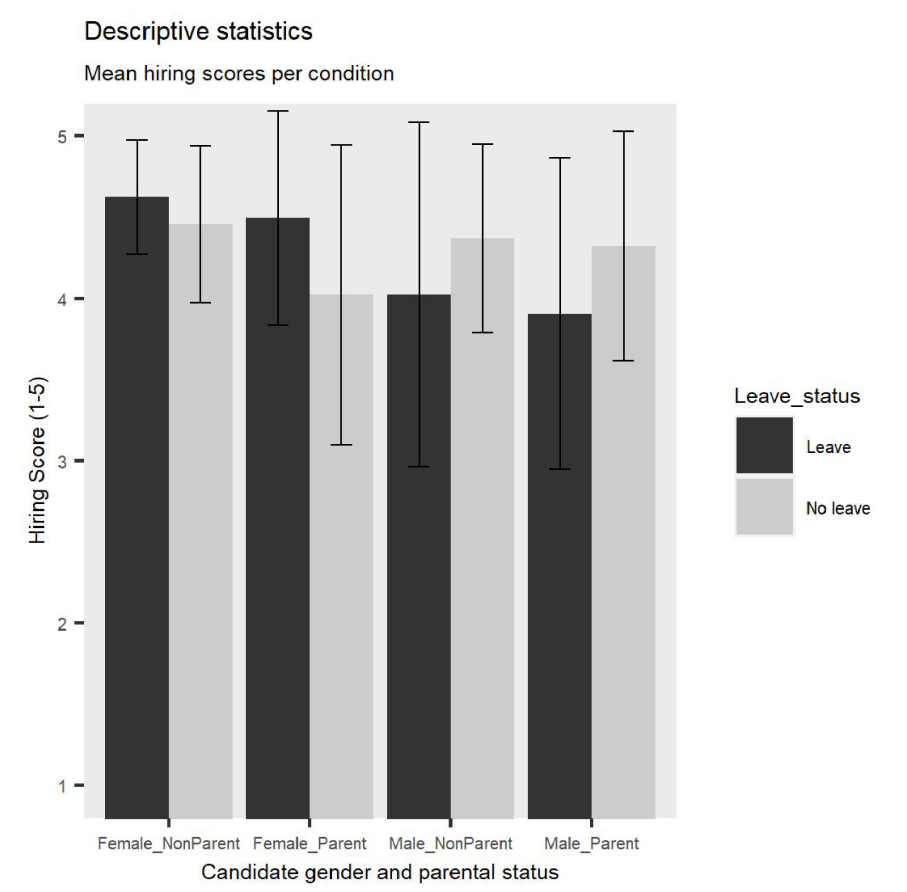
Fig 2. Descriptive statistics reflecting mean hiring scores. Error bars represent Standard Deviation